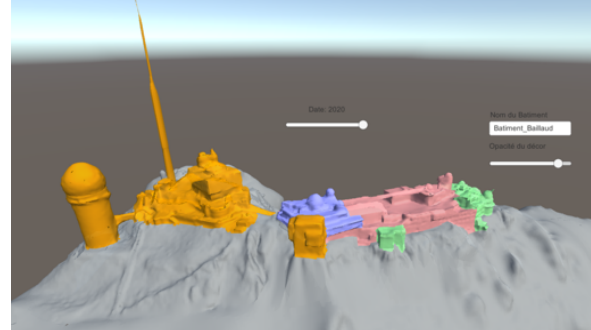
Figure 2. The global photogrammetric model in the Unity